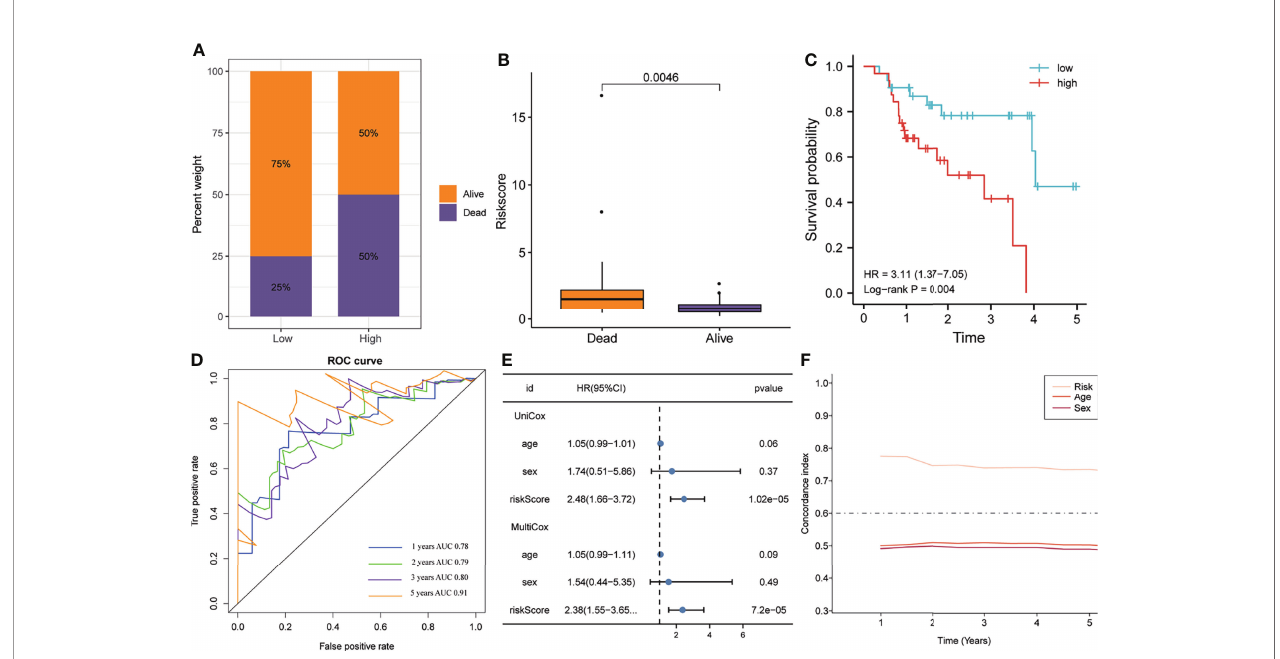
FIGURE 4 | The predictive ability of the gene signature in the validation cohort. (A) The distribution of survival status in the high- and low-risk groups. (B) The distribution of the gene signature risk scores between patients who have died and patients who are alive. (C) Survival curves were plotted using the Kaplan – Meier method and compared using the log-rank test. (D) The area under the receiver operating characteristic curve value of the risk model for 1-, 2-, 3- and 5-years is 0.78, 0.79, 0.80 and 0.91 respectively. (E) Univariate and multivariate Cox regression analyses of the risk model. (F) Time-dependent concordance index exhibits the excellent predictive ability of the risk